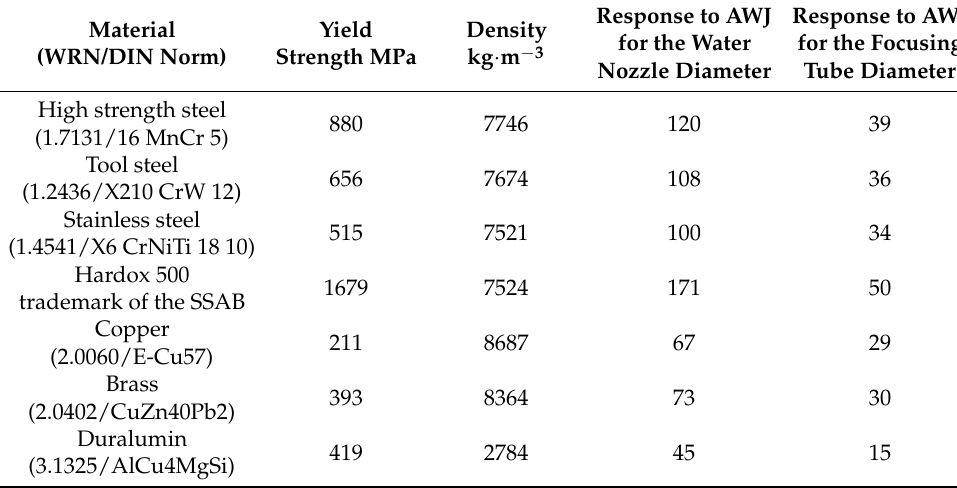
Table 2. Parameters of metals; all samples were 10 mm thick.